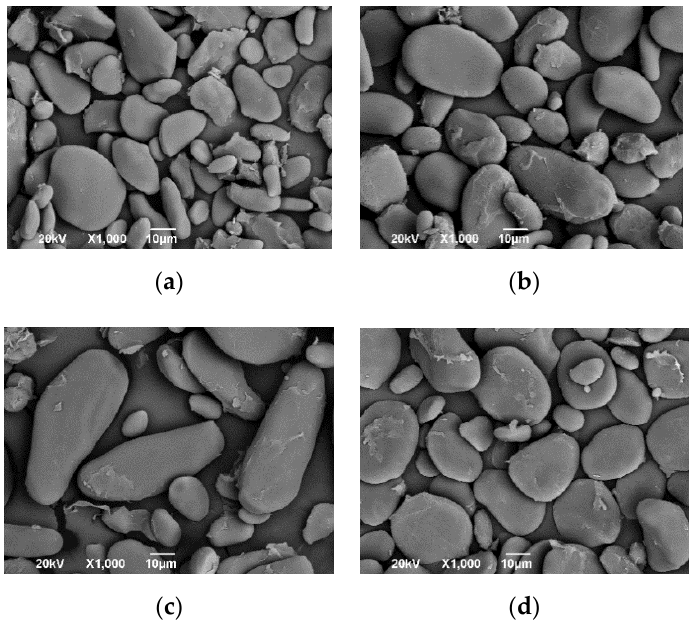
Figure 1. SEM micrograph of plantain starch granule of four varieties: ( a ) Gros Michel; ( b ) Dominico; ( c ) Cachaco; ( d ) Guineo.